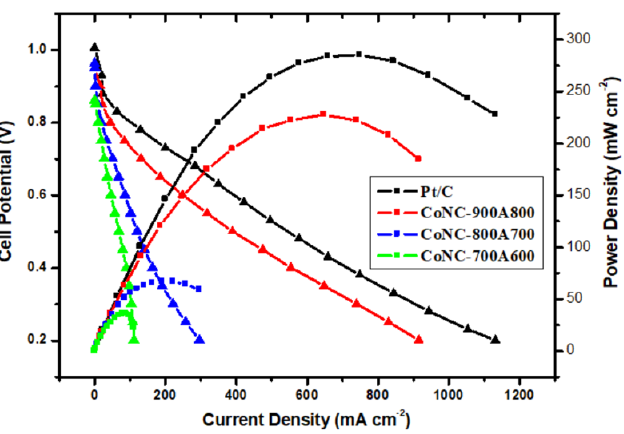
Figure 10. I-V polarization curves and power density of various Co – N – C cathode catalysts.